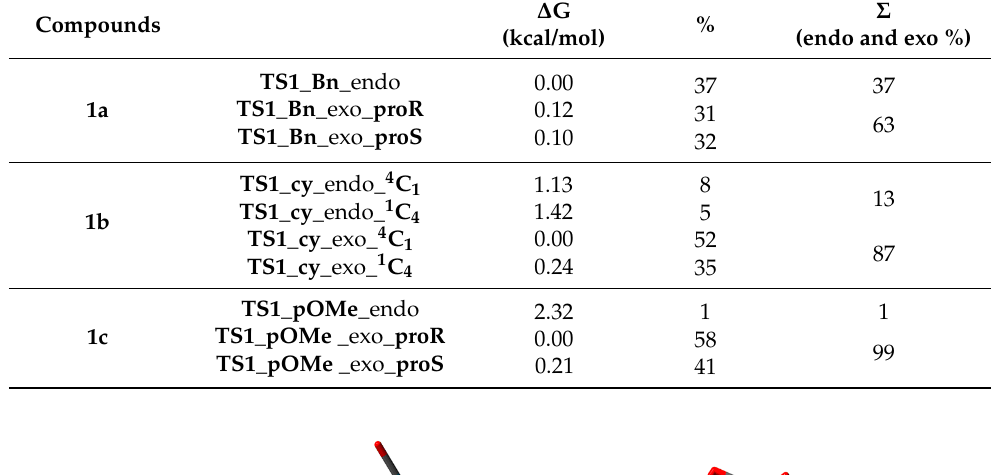
Table 1. Relative free energies (kcal/mol) of TSs and percentages of the corresponding products at 298 K of the oxidation reaction with RuO 4 of compounds 1a – c .